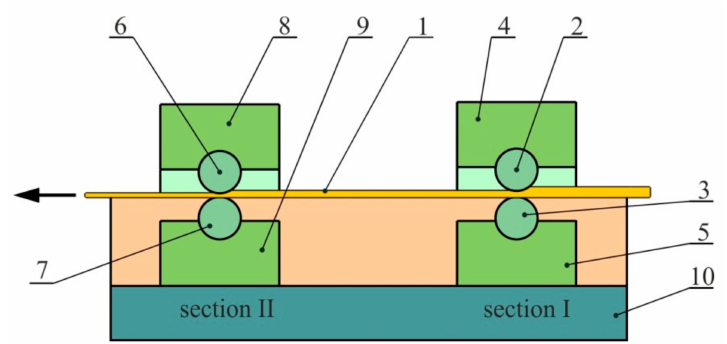
Figure 15. Schematic diagram of an SRT with a textured tool surface: 1—specimen; 2, 3, 6, 7—stationary cylindrical tool pins; 4, 8—housing; 5, 9—heater blocks; 10—base; prepared based on [33].